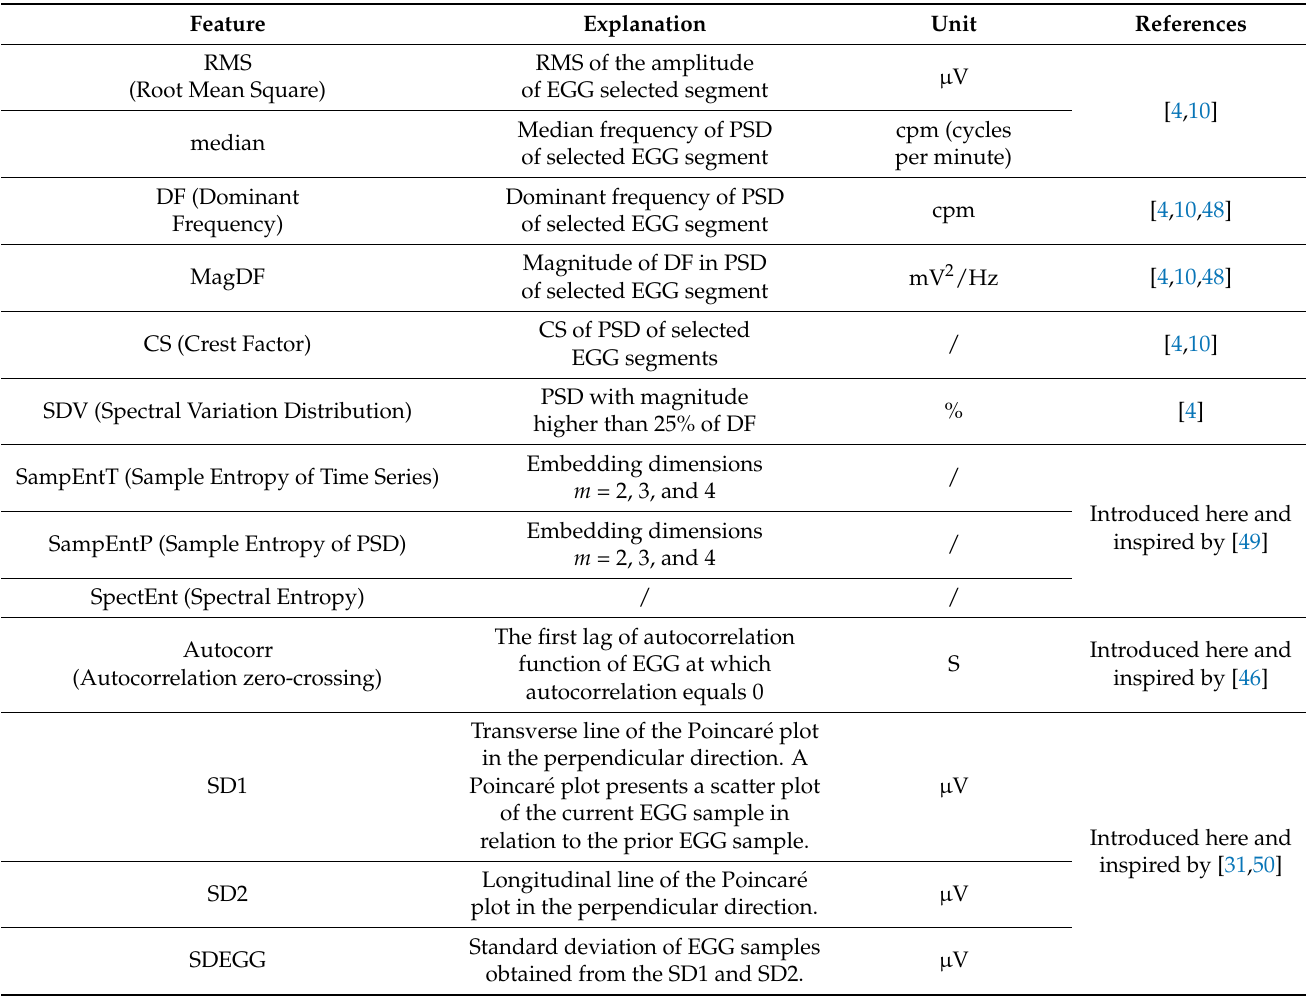
Table 1. 17 EGG-based features calculated from EGG segments recorded during a simulated drive in 17 subjects (SampEntT and SampEntP are separately evaluated for embedding dimensions m = 2, 3, and 4). The number of observations for all four segments is 17 × 4 = 68 and the total number of features for 17 subjects is 17 × 68 = 1156. PSD stands for Power Spectral